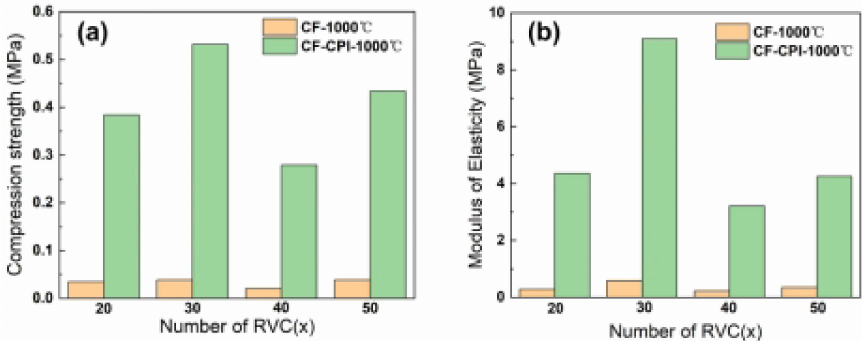
Figure 12. Compressive strength ( a ) and elastic modulus ( b ) of CF and CF-CPI-1000 ◦